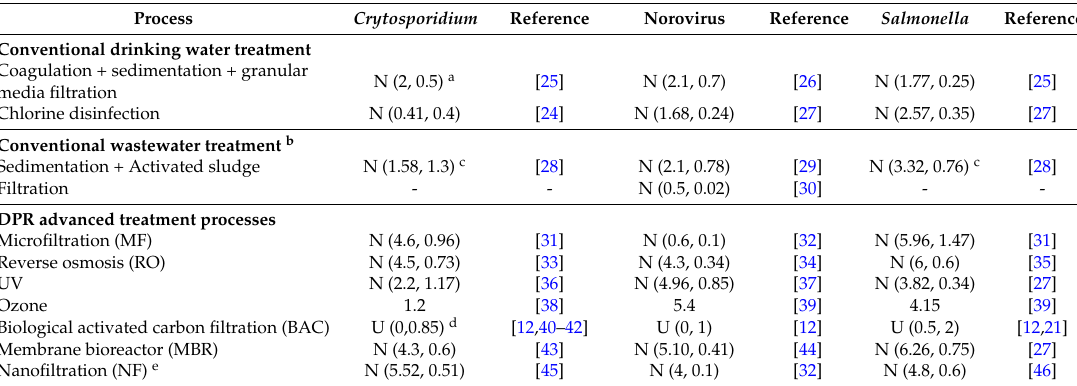
Table 3. Monte Carlo parameters for treatment process log removal